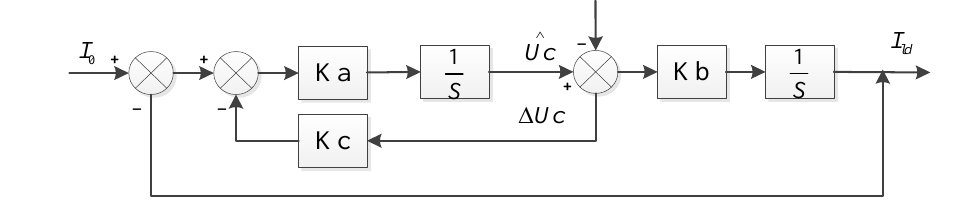
Figure 5. Block diagram of load current observer